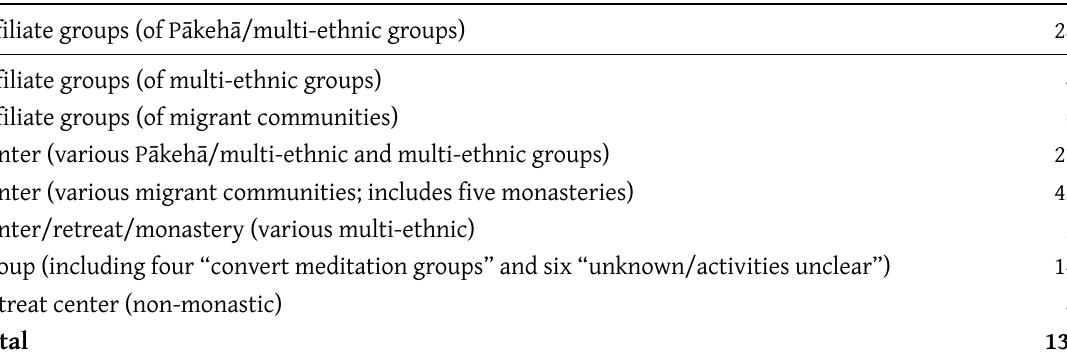
Table 4: Buddhist communities and groups by mode of operation,